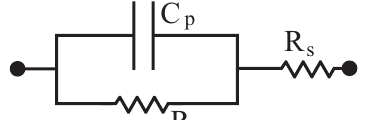
Figure 2: The basic current model for corrosion.